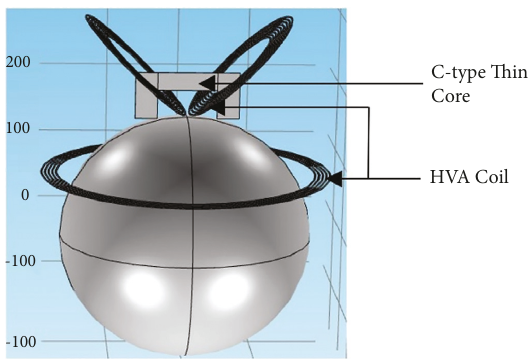
Figure 7: The HVA coil with C-type thin